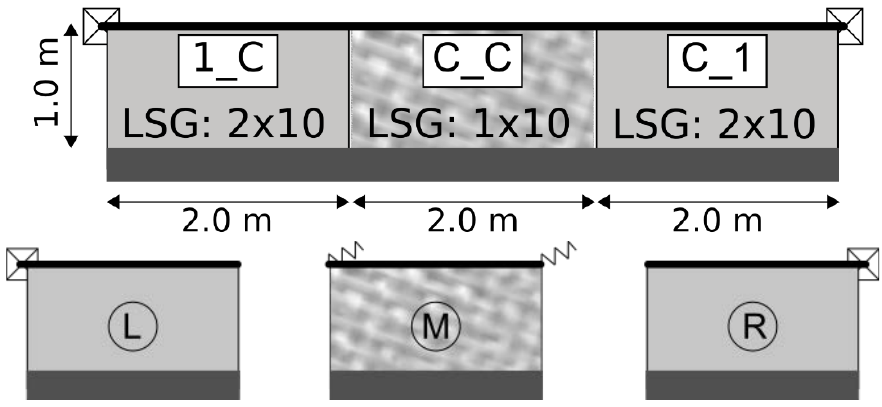
Fig. 4 Overview of the selected system and the signle pane systems for the simplified design method.